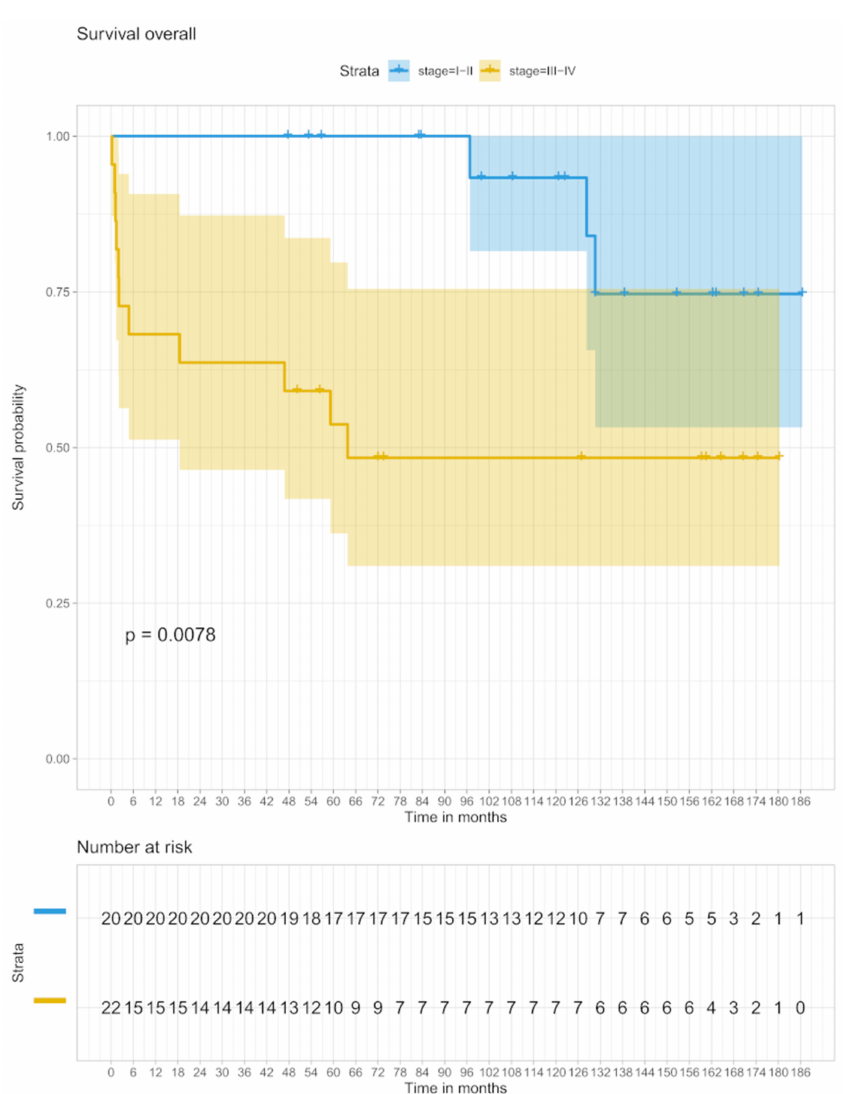
Figure 3. OS in stage I/II and stage